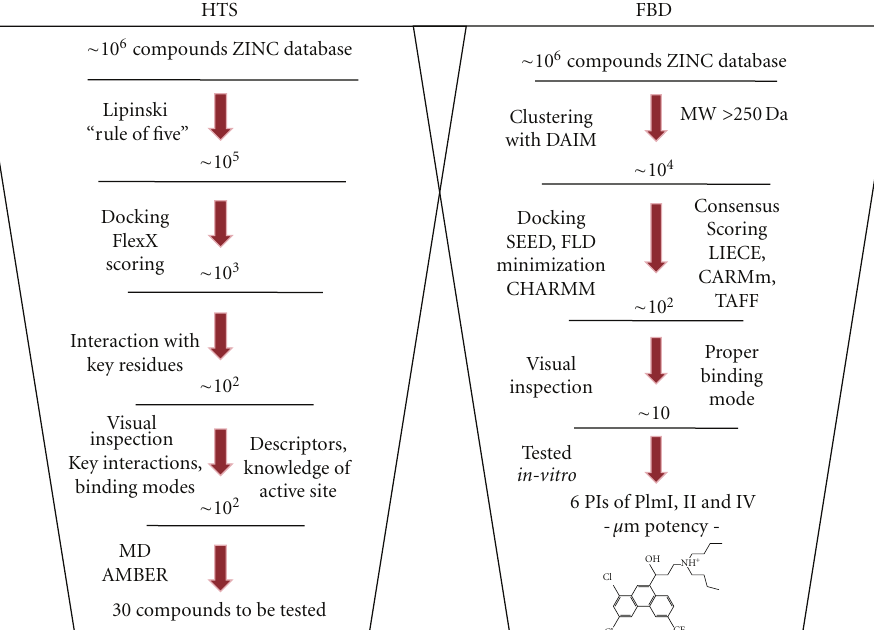
Figure 3: Overall scheme of in silico screening strategy applied to Pf plasmepsins. FBD represents the fragment-based docking process performed by Friedman and Caflisch [28], and HTS the high throughput screening carry out by Kasam and colleagues [29]. Details can be revised in the corresponding references.